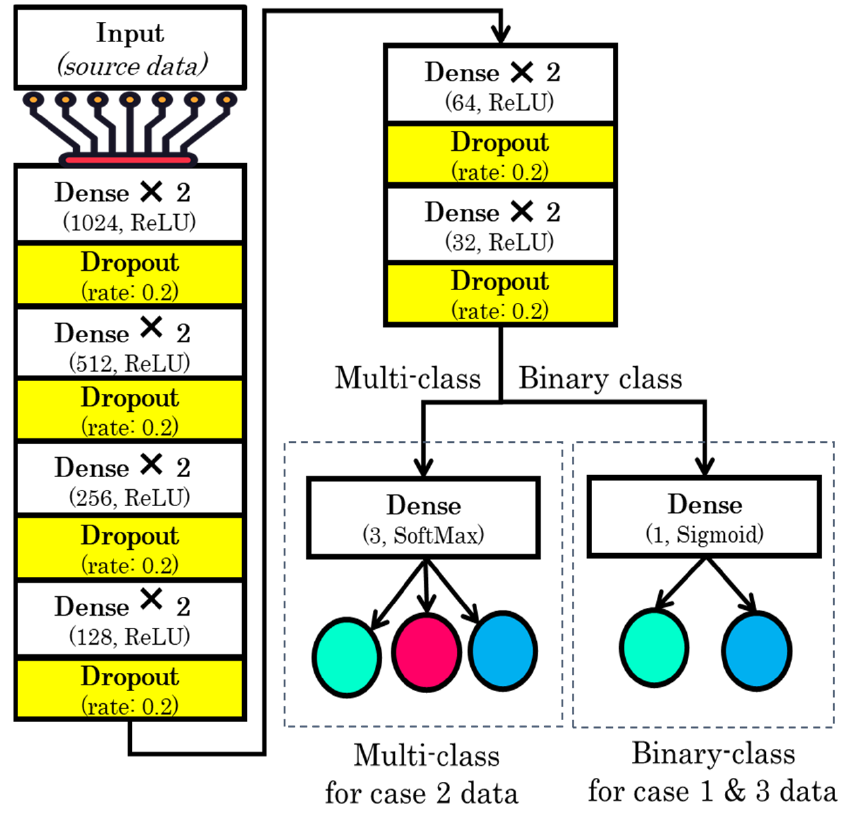
Figure 7. Structure of the proposed model.